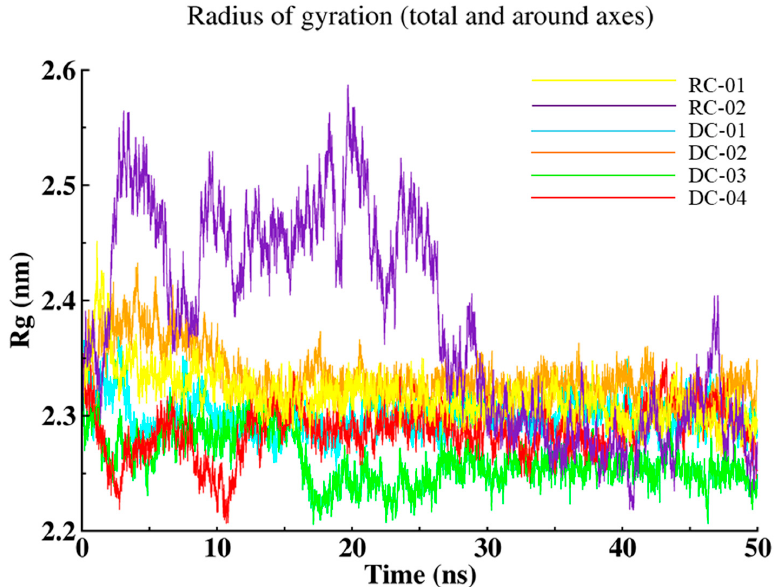
Figure 6. The overall Rg plot for designed and reference compounds for 50 ns.